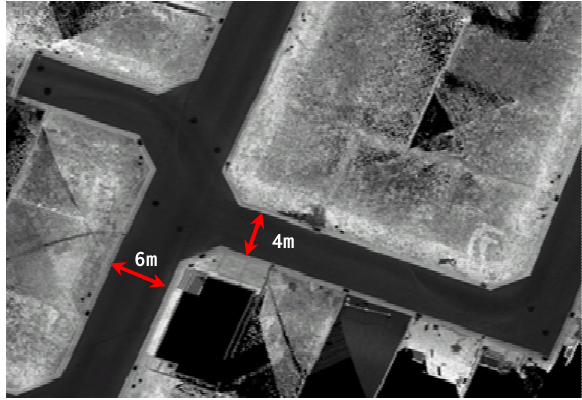
Figure.5 Measurement of road width on road surface ortho-